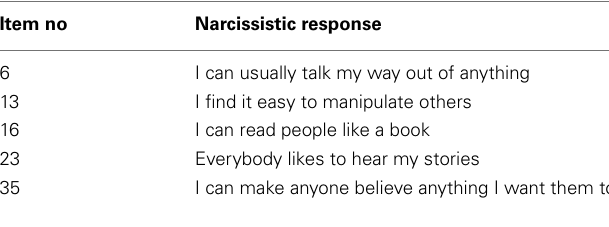
Table 1 | NPI exploitativeness subscale (Raskin andTerry, 1988)